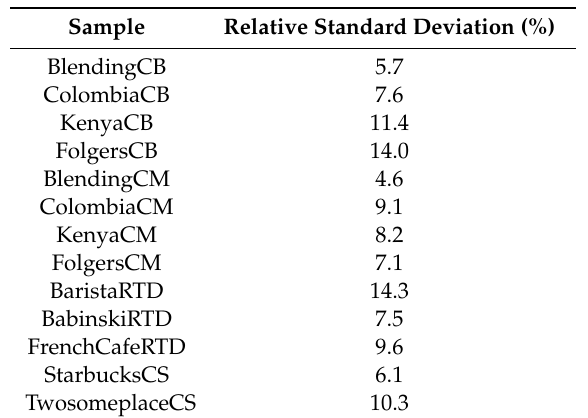
Table 5. The relative standard deviation as a percent for the IS (1,3-Dichlorobenzene) peak abundance (average of three repetitions) for each co ff ee sample.